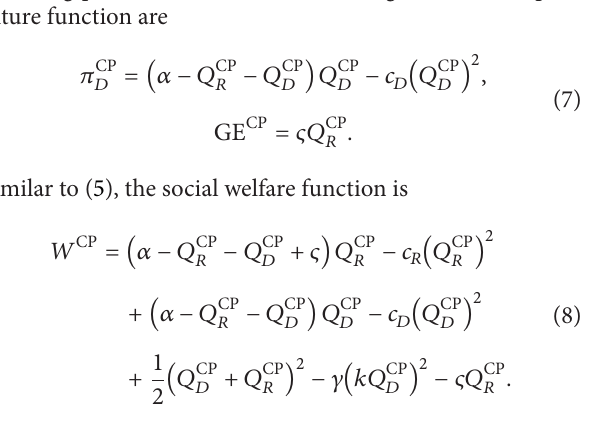
Figure 2: Constant-premium price model.